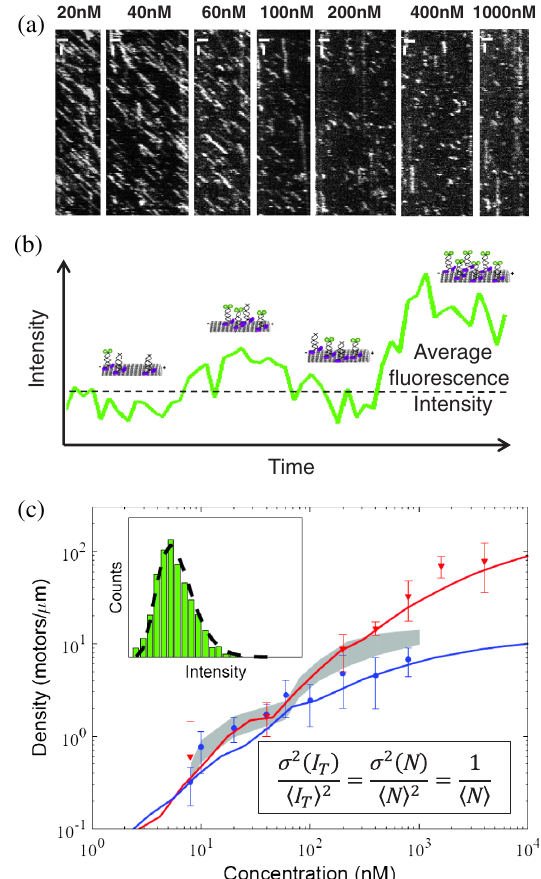
FIG. 3. Measurement of motor protein density from intensity fluctuations. (a) Kymographs [time-space plots; scale bars: 1 μ m (horizontal) and 1 s (vertical)] of kinesin-1 motility assays. The total of labeled and unlabeled motor concentration is indicated. Fluorescently labeled kinesin-1 concentration is 20 nM in all experiments. (b) Sketch of intensity fluctuations over time by random attachment and detachment of motors. (c) Motor density (labeled þ unlabeled) on microtubule as a function of motor concentration in solution calculated from the intensity fluctua- tions. The density is obtained per microtubule for kinesin-1 (blue dots, 117 microtubule segments) and OSM-3 (red triangles, 76 microtubule segments). Error bars are standard deviations calcu- lated for each concentration. Solid curves of the corresponding color show predictions of the extended TASEP-LK model (see main text). Grey shading (mean (cid:2) standard deviation) indicates the estimate of density from manual particle counting of kinesin- 1. Inset: The normalized intensity follows a Poisson distribution (dashed line). Motility assays are performed in a PEM80 buffer. Numerical values of the experimental data used for fitting in panel (c) are listed in Table 2 in Ref.